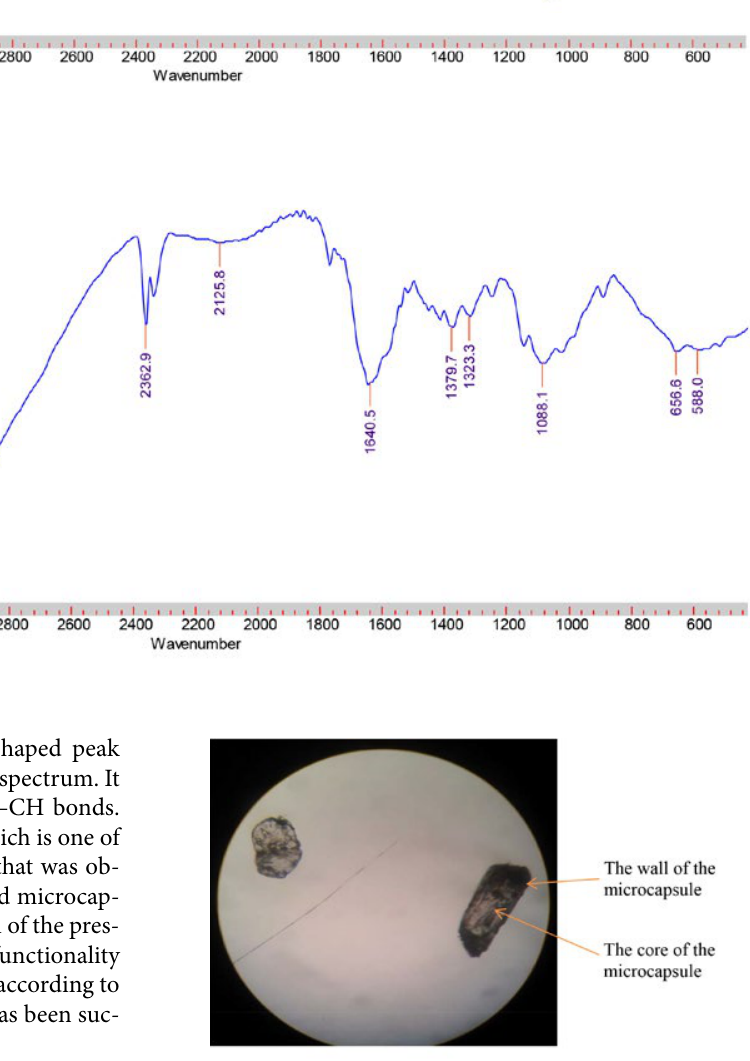
Figure 5 . An optical microscopic image of lime oil microcapsules (× 100